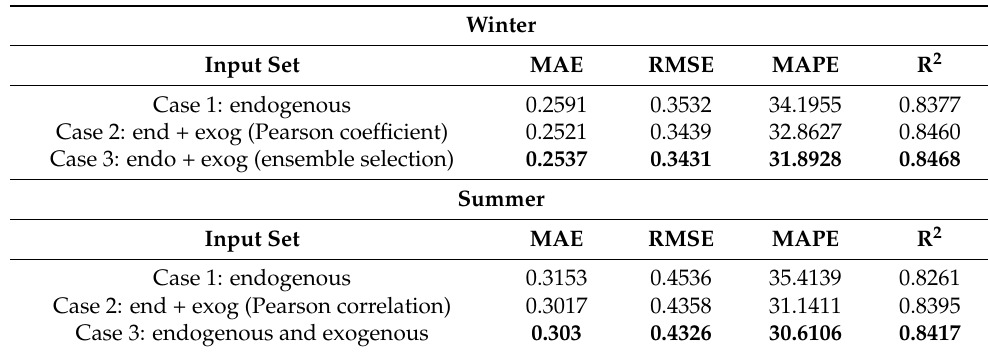
Table 5. Comparison of forecasting performance for different input datasets using